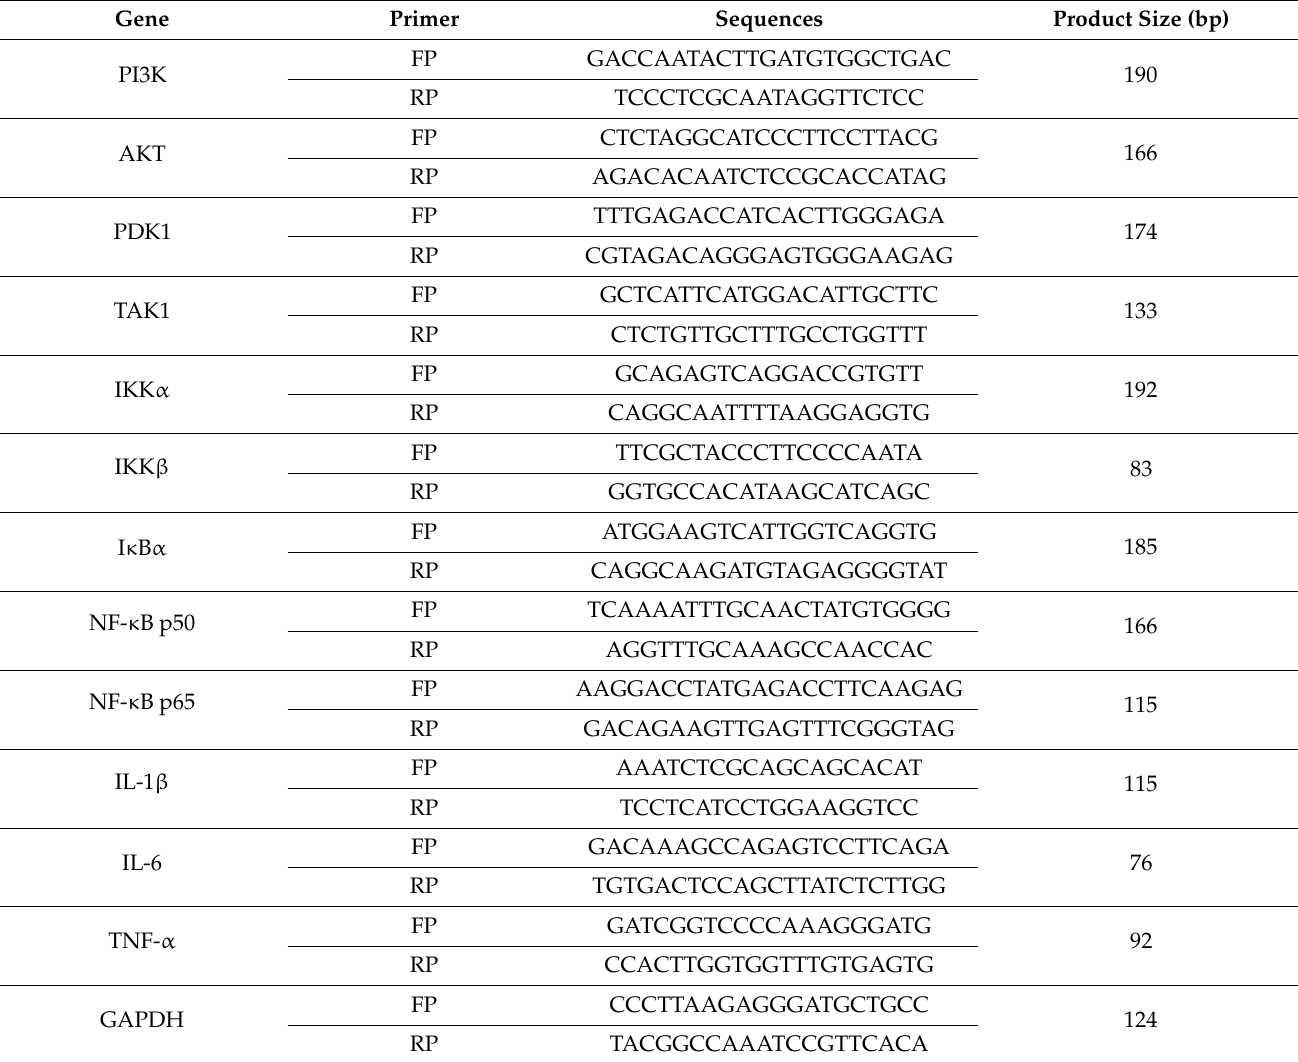
Table 1. Primer sequences of the